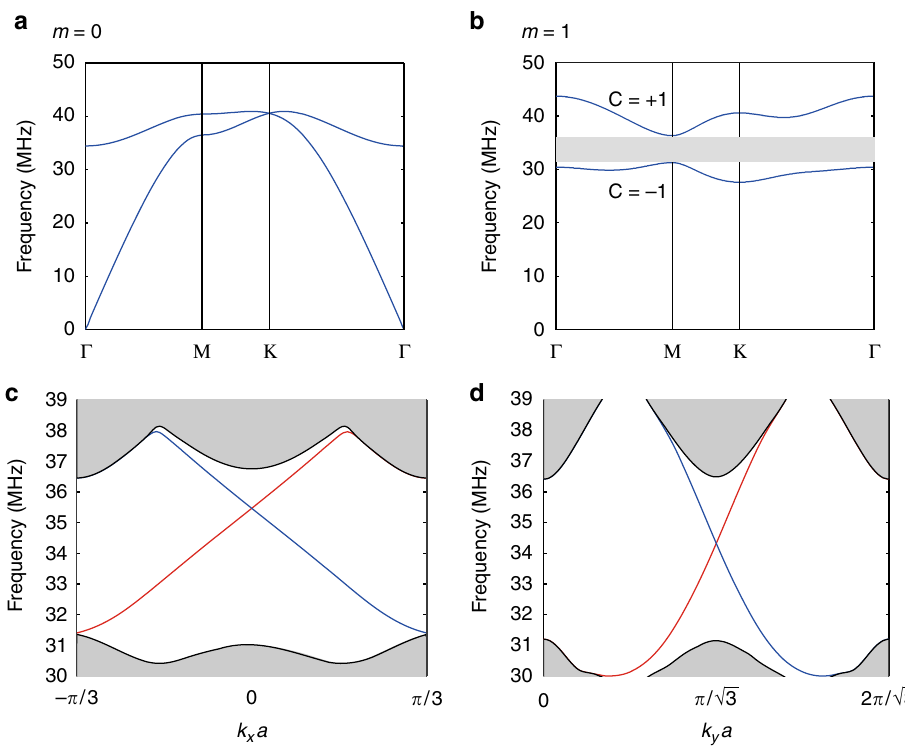
Fig. 2 Band structures and edge states. a , b The bulk bands for m = 0 ( a ) and m = 1 ( b ). The Dirac point exists at K for m = 0 and the degeneracy is lifted for m = 1 bands which possess non-zero Chern numbers as labeled in ( b ). The band gap (gray region) between the two bands is nontrivial. The band structure for m = − 1 is the same as that in ( b ) but the Chern numbers have opposite signs. c , d The projected bands for m = 1 along the x direction ( c ) and y direction ( d ), where the gray area represents the projected bulk bands and the red and blue curves represent the edge states localized at the upper (right) and lower (left) boundaries of a ribbon of this system. The ribbon is periodic along x ( y ) and truncated with an armchair (zigzag) boundary in the y ( x ) direction. In the calculation, the intralayer and interlayer cable lengths are a = 0.43 m and b = 2.06 m, respectively. The wave speed is 0.66 c and the cable loss is